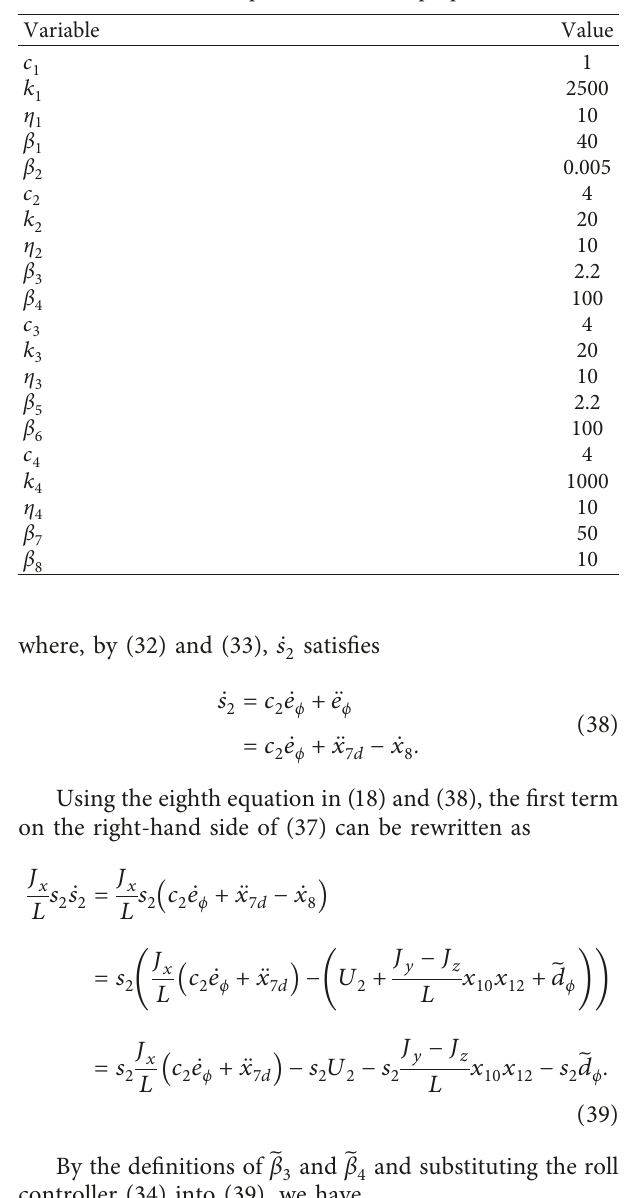
Table 2: Controller parameters in the proposed